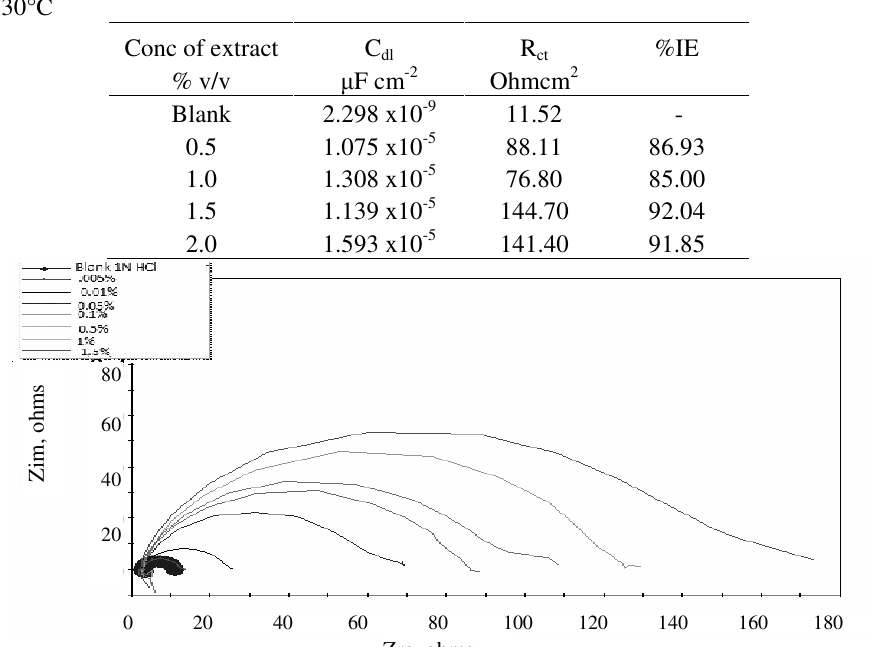
Figure 7. Impedance plots recorded for mild steel in 1 N HCl solutions without and with various concentrations of MNP